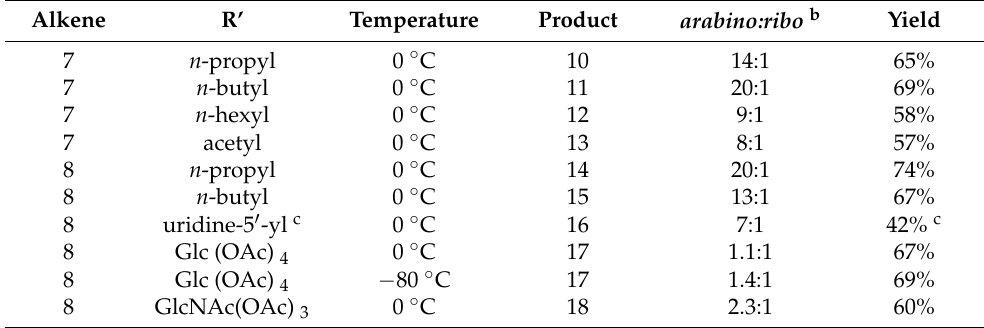
Table 1. Photoinitiated hydrothiolation reactions of 2 (cid:48) -exomethylene nucleosides 7 and 8 a . Alkene